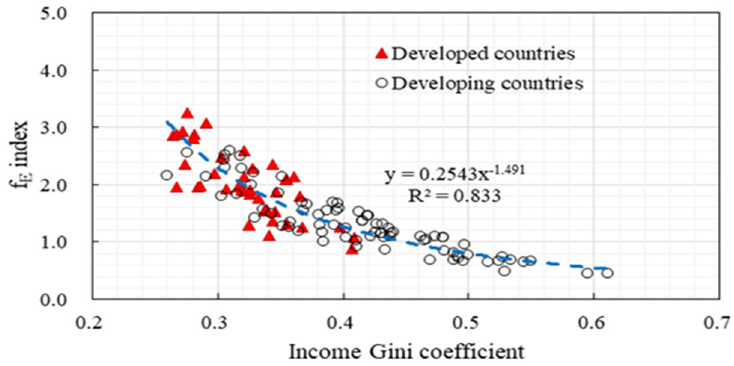
Figure 3. f E index vs. income Gini coefficients, based on the data from World bank. Table 2. Equity interpretation.